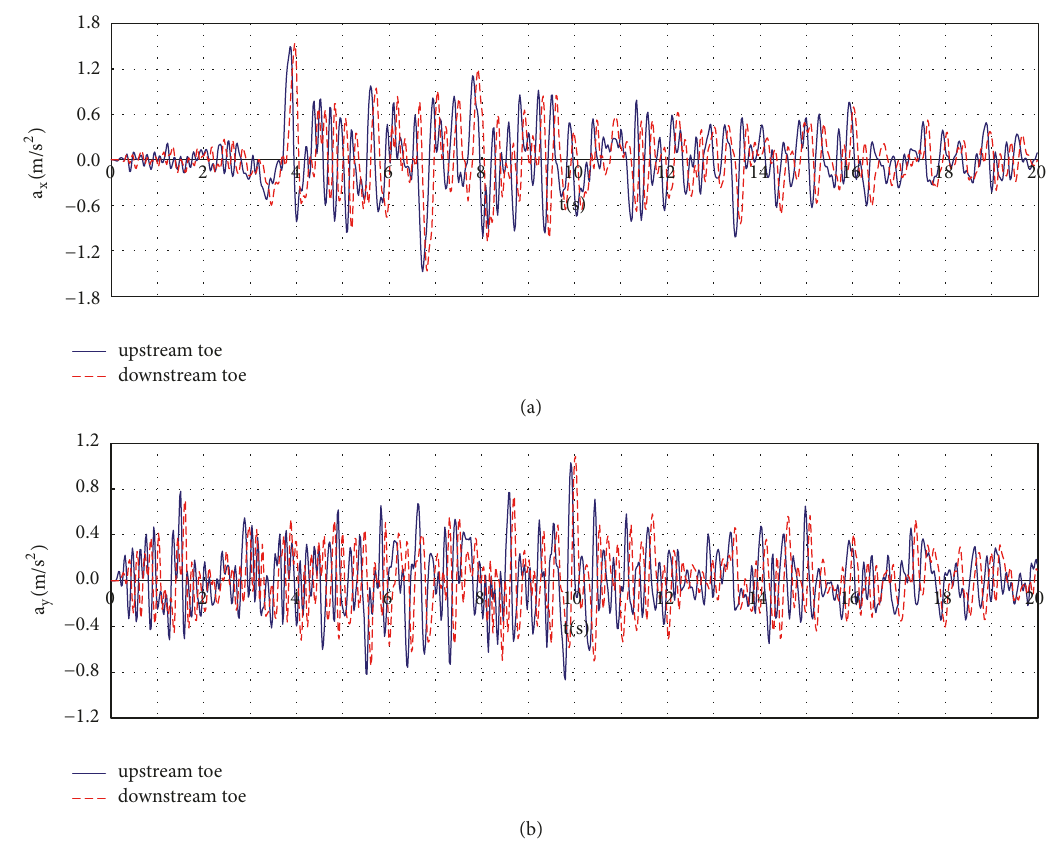
Figure 22: Time histories of acceleration at the upstream toe and downstream toe: (a) horizontal and (b)